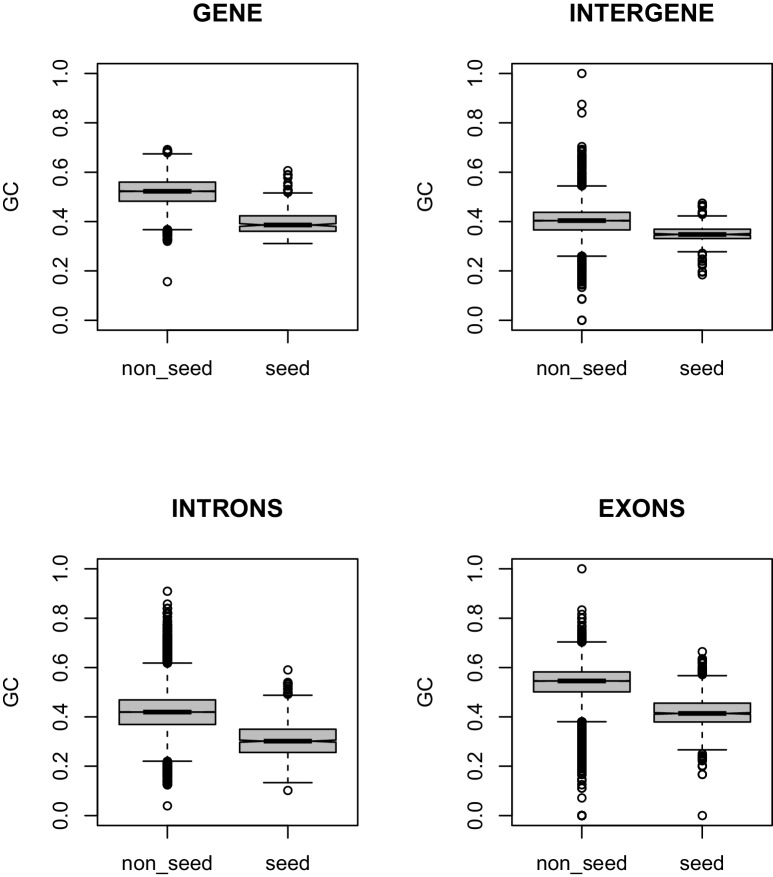
GC-content of different functional categories in seed and non-seed regions of Muller A, B and E of D. subobscura.